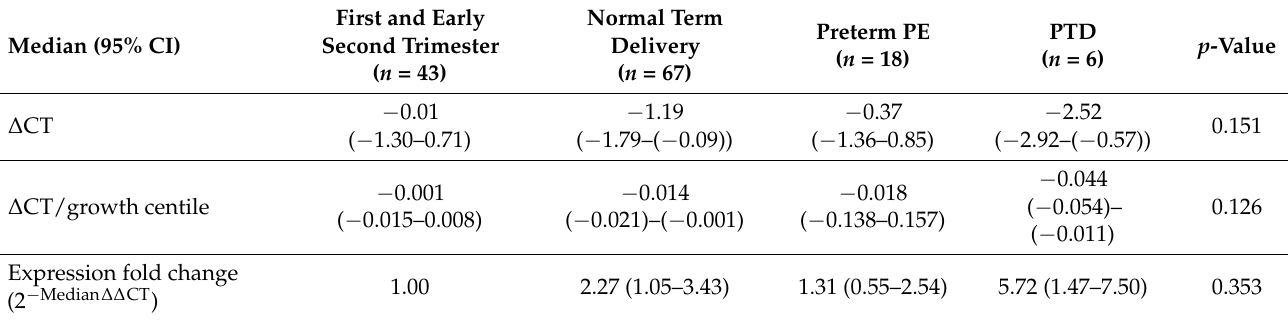
Table 2. Placental CD24 mRNA